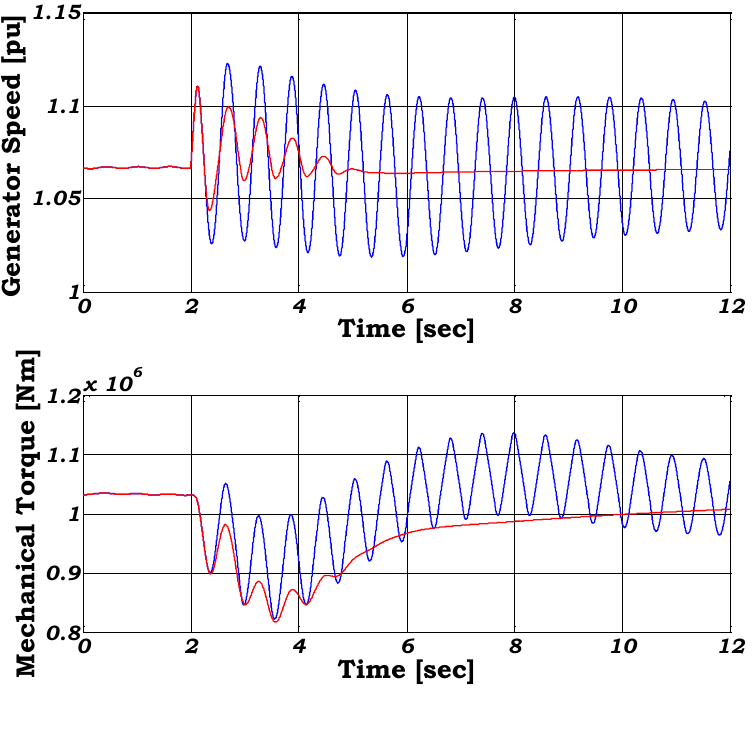
Figure 5. Generator speed and mechanical torque during voltage dip with (red line) and without damping controller (blue